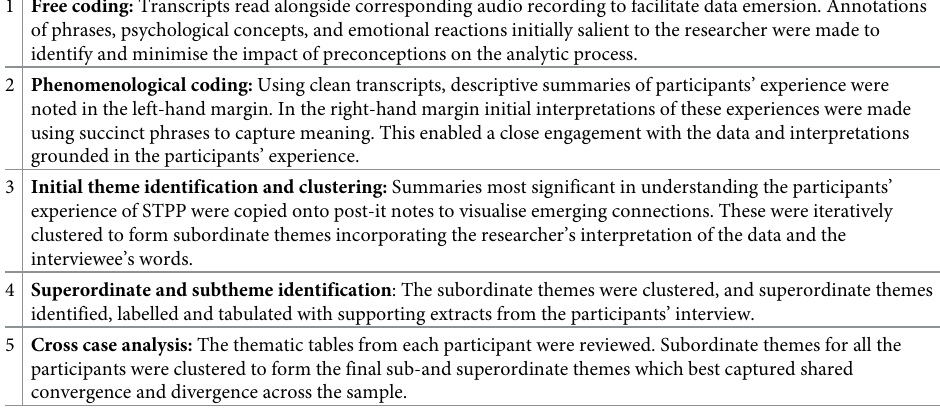
Table 2. Data analysis